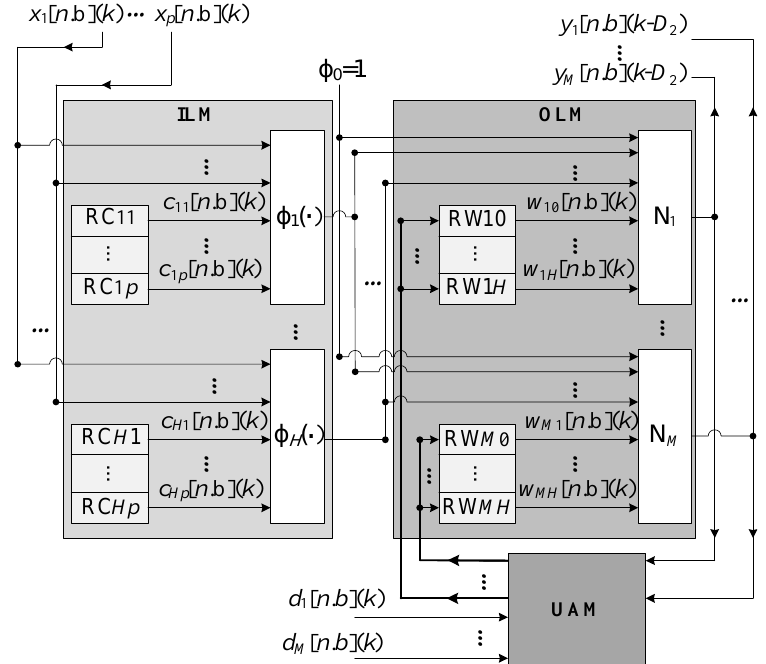
Figure 2. General structure of the RBF network implemented in an